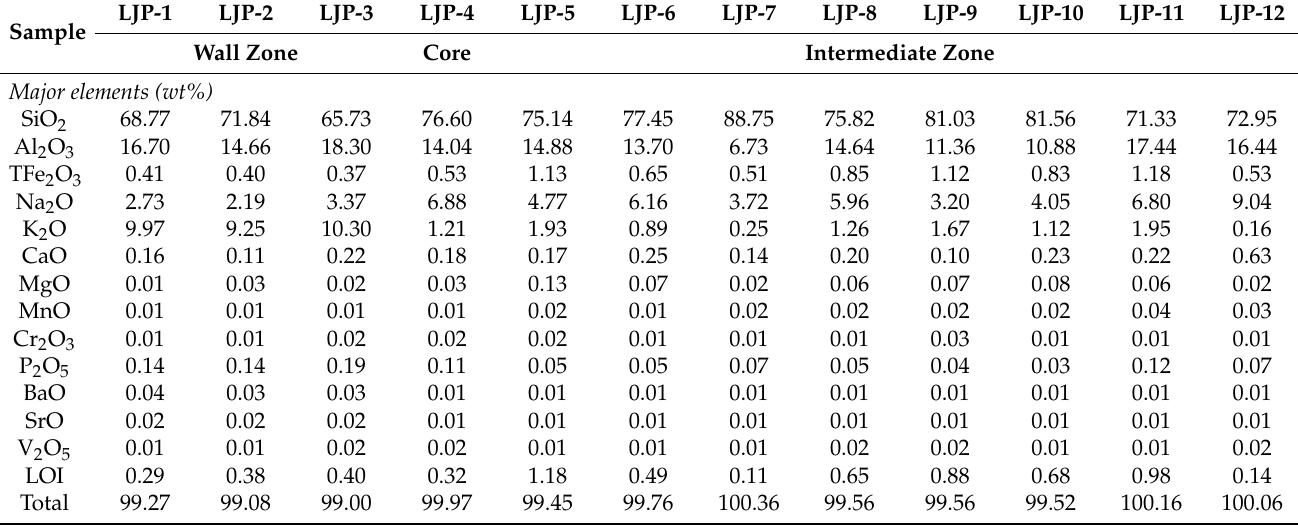
Table 2. Major, trace and REE data for pegmatite in the Lijiapuzi ore